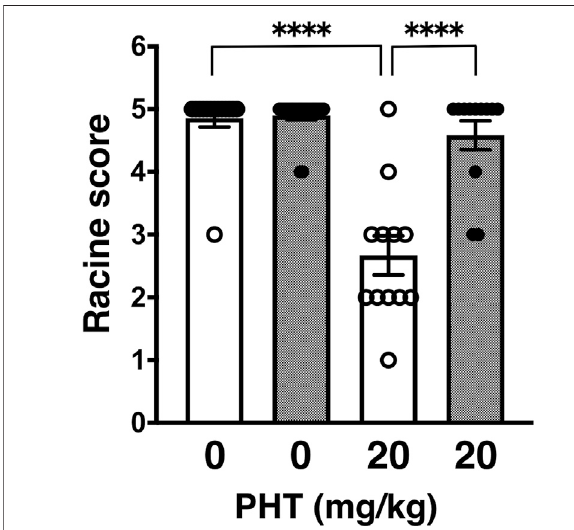
FIGURE1| Inhibitoryeffectsofphenytoin(PHT)onPTZ-evokedseizure. Effects of PHT on occurrence of generalized tonic-clonic seizures. Seizure scores of adult male wild-type (white dots and white bars) and GluA1C811S (blackdotsandhashedbars)micereceivedanadministrationofPHTata doseof0or20 mg/kg, 30 minbeforeasingleinjection of60 mg/kgPTZ. Four bars: n (cid:1) 14, 20, 12, 12 mice (left to right). Error bars represent s.e.m. ANOVA with Fisher ’ s LSD post hoc test. **** p < 0.0001.